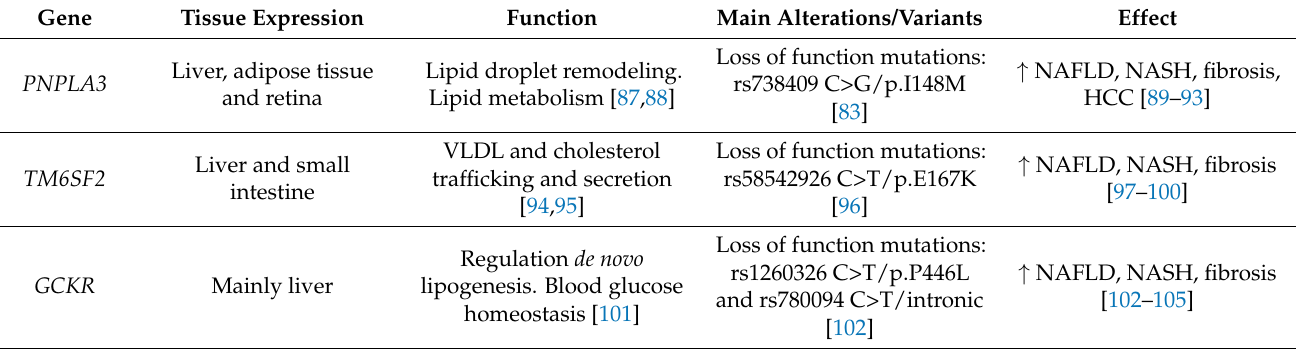
Table 1. Genes associated with NAFLD pathogenesis and